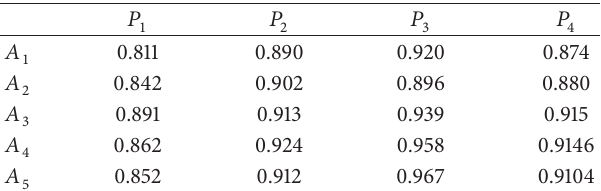
Table 5: Activity-level assessment results.